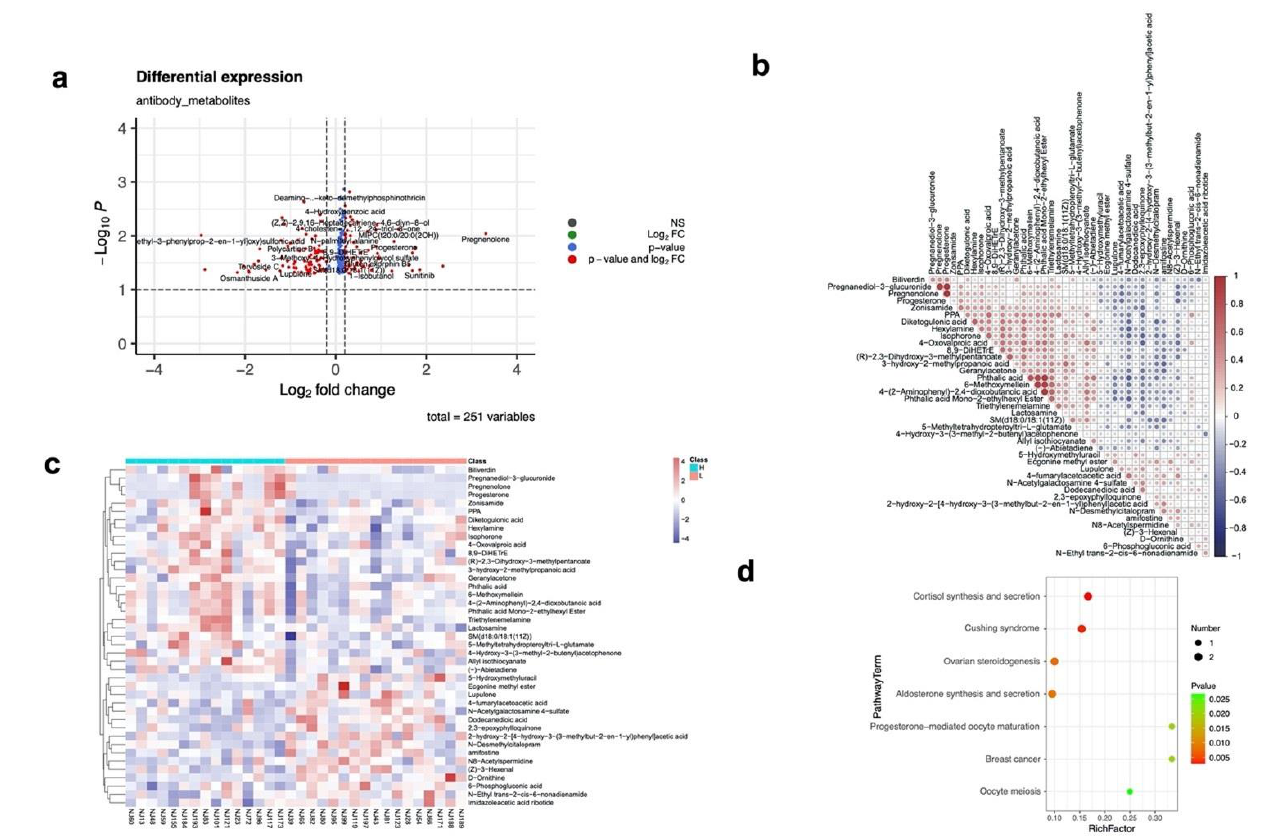
Figure 3. The differential metabolites in the high − and low − antibody groups. ( a ) The differential metabolite expression identified in the high- and low-antibody groups. The x axis shows the log2 fold change in metabolites for two groups (high antibody group vs. low antibody group), and the y axis represents the − log10 p values of the metabolites. ( b ) The similarity of the differential metabolite distribution identified in the high − and low − antibody groups. ( c ) The heatmap of differential metabolites distribution in the high − and low − antibody groups. ( d ) The KEGG enrichment pathways of the differential metabolite distribution identified in the high − and low − antibody groups.